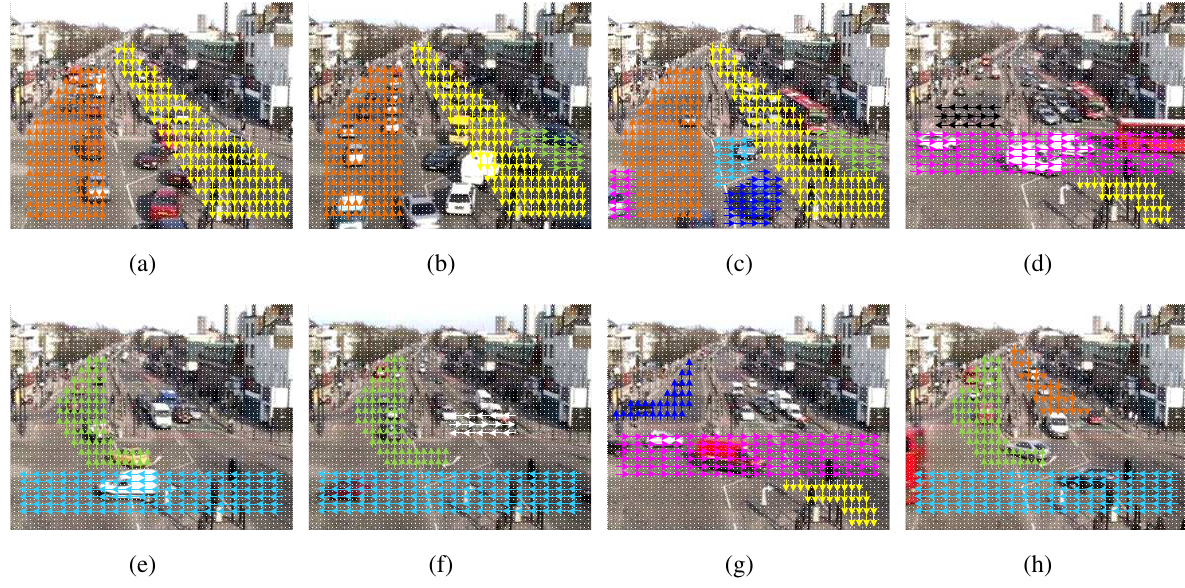
Figure 5. Traffic activities discovered by PAM. ( a – c ) The vertical traffic behavior; ( d – h ) the horizontal traffic